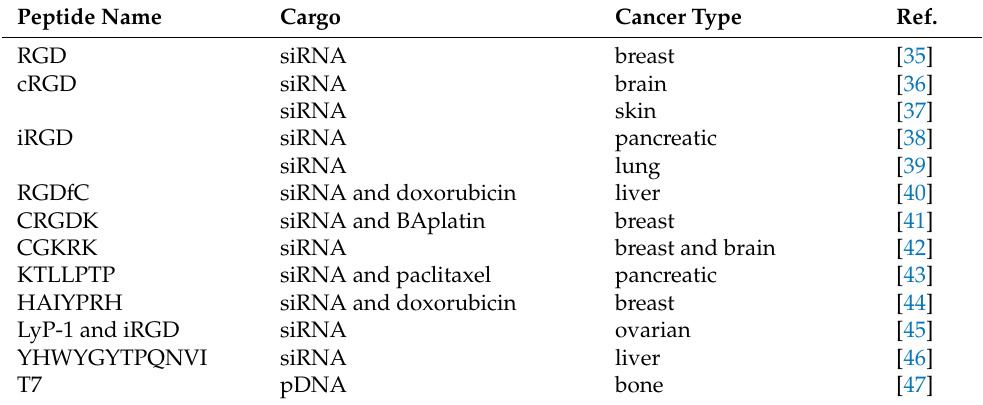
Table 1. Examples of peptides used for targeting in cancer gene